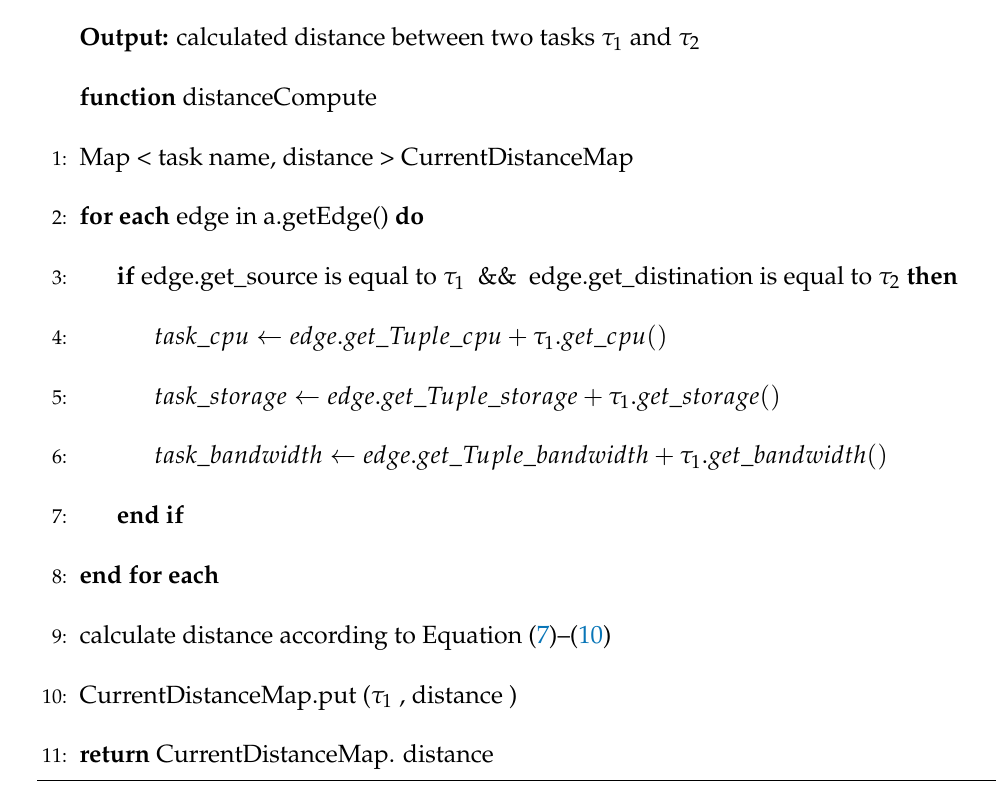
Algorithm 2 Compute distance of